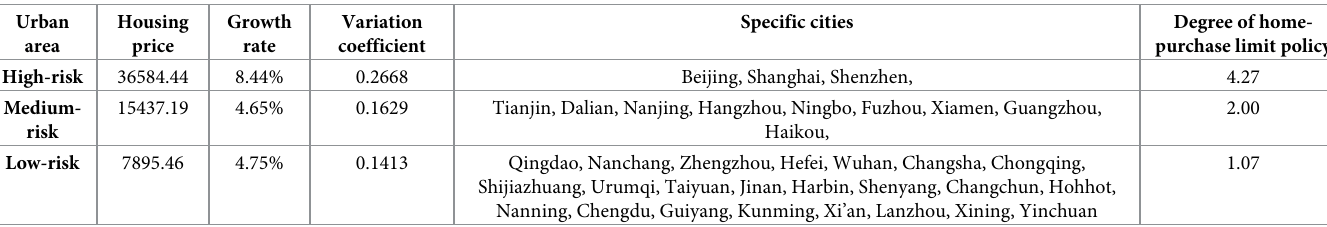
Table 7. Attributes and classifications of urban housing market of